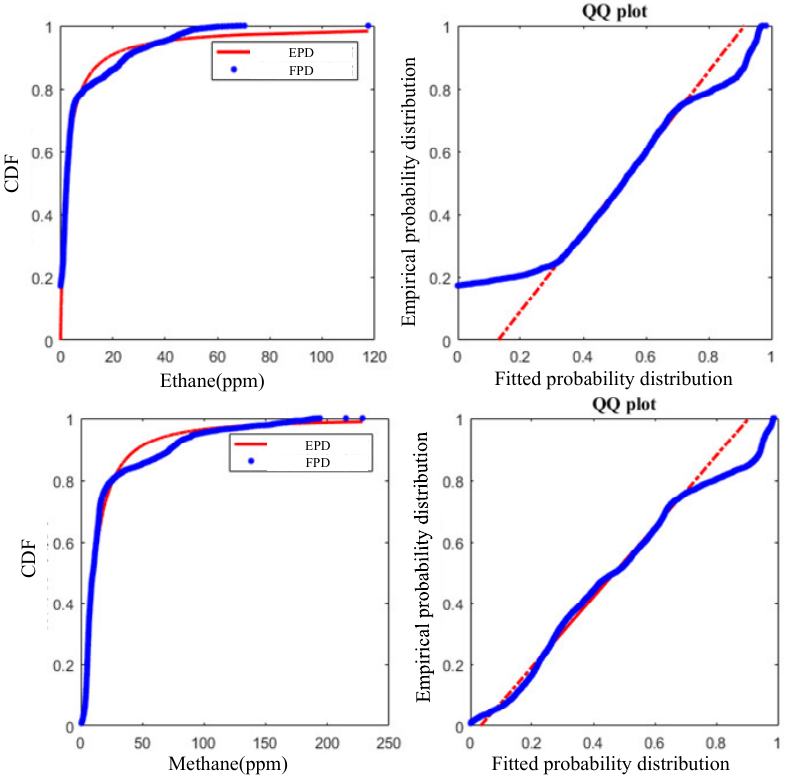
Figure 3. Marginal distribution fitting results of methane and ethane.